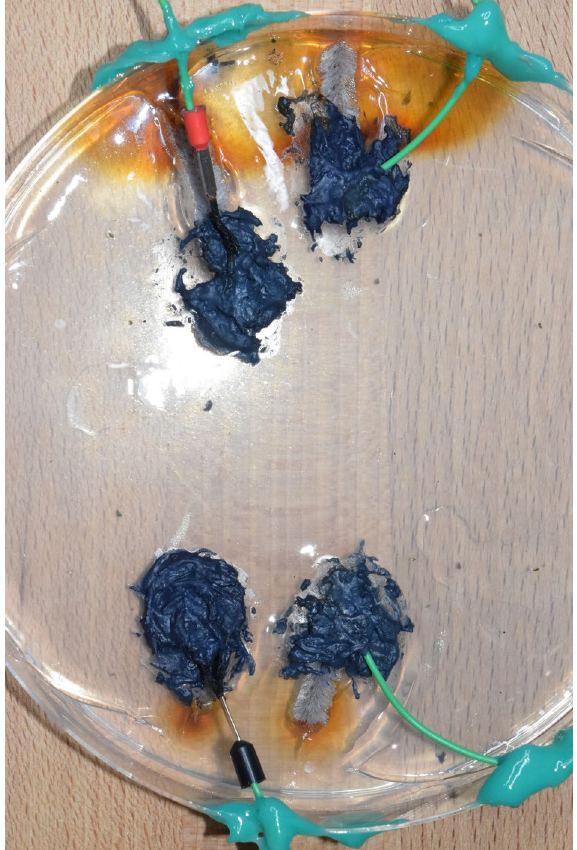
Figure 5. PEDOT Polymer electrode on agarose plate. Right: green metal leads directly in the electrode, Left: conductive textile interface between electrode and metal wire. Electrode diameter: 2 cm.